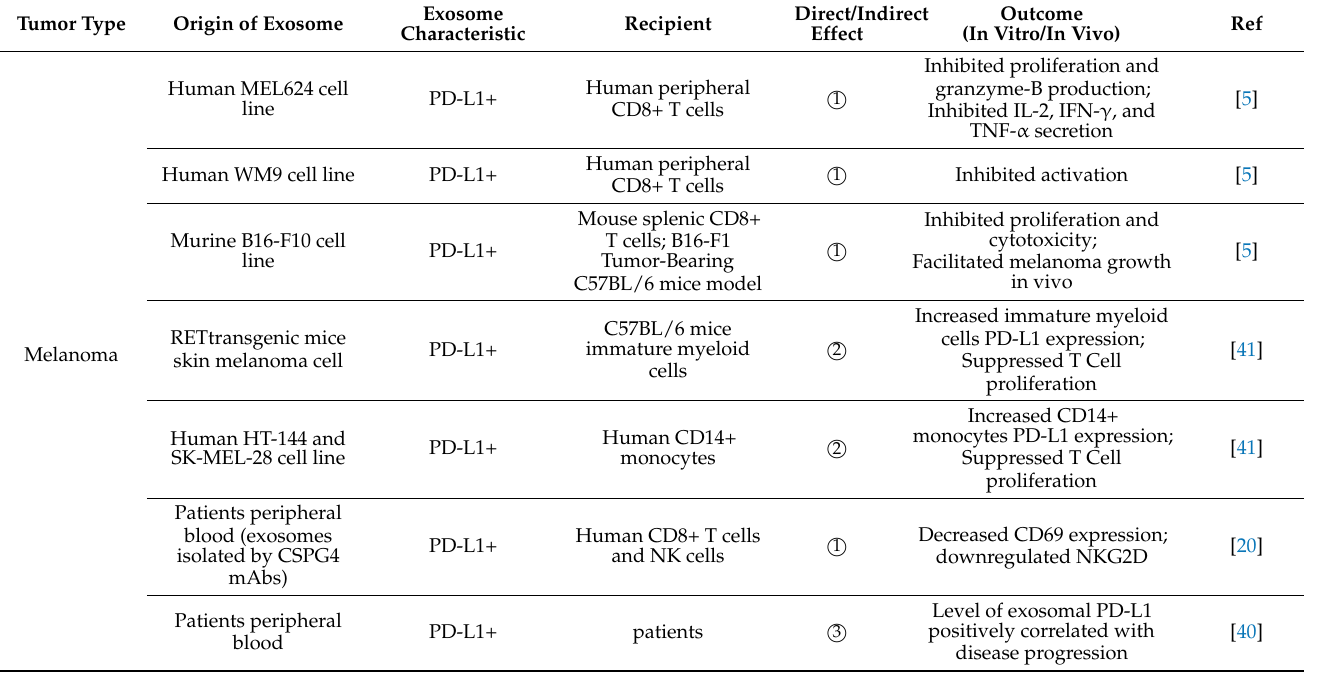
Table 2. Effects of exosomal PD-L1 from various tumors on T cells and